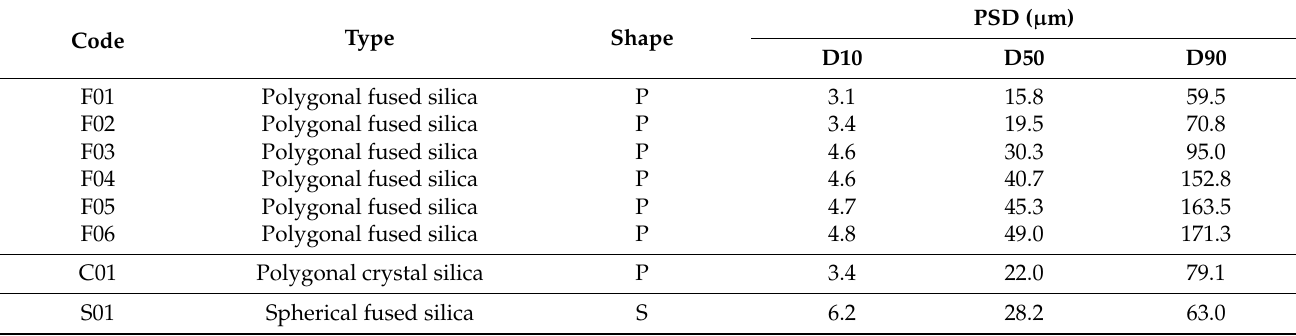
Table 1. Filler type, shape, and particle size distribution